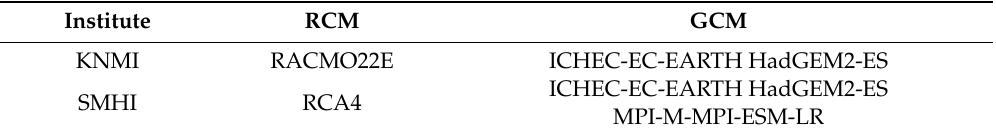
Table 1. List of regional climate models (RCMs) and global climate models (GCMs) used in this study. The five simulations of this paper use the KNMI (SMHI) regional climate model with boundary conditions from two (three) di ff erent global models, which make the combined modeling systems substantially diverse so as to be considered as di ff erent